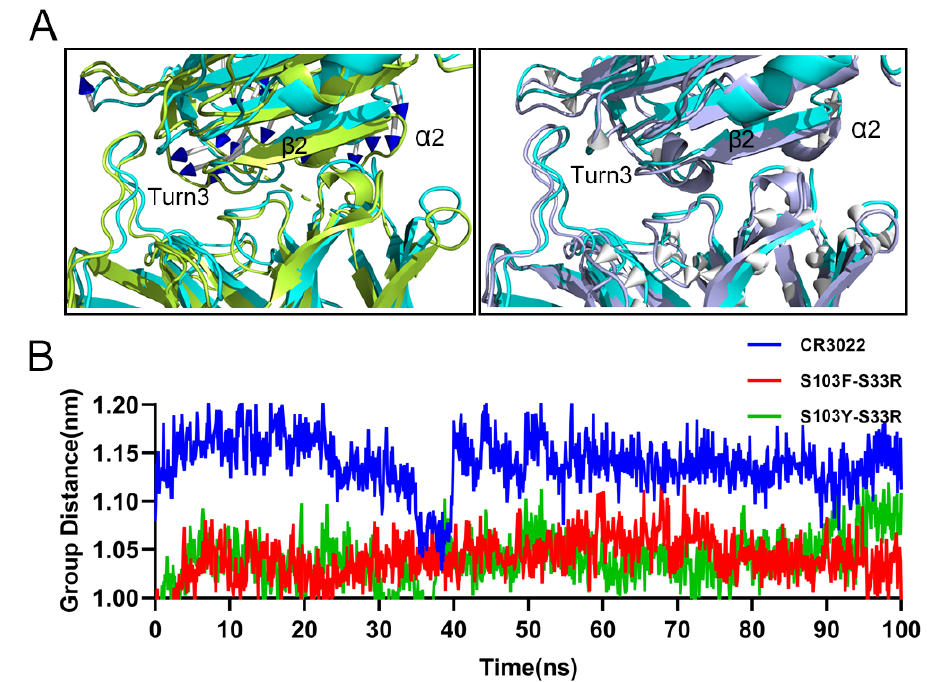
Figure 8. The time-dependent distance changes analysis between the CDR group and the epitope